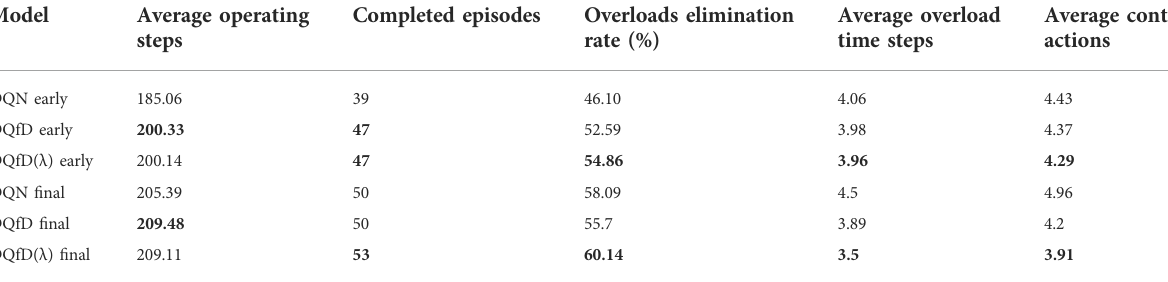
TABLE 3 performance comparison between the DRL models.